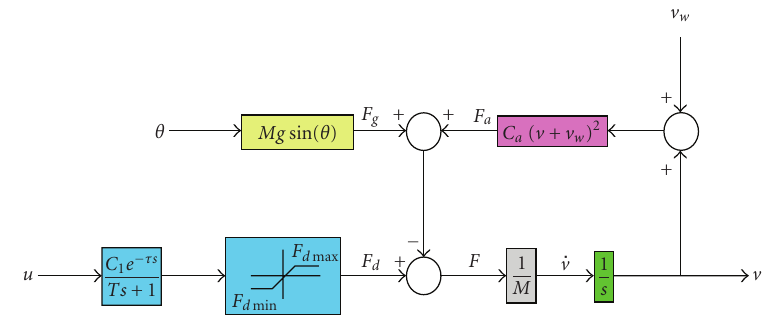
Figure 2: A block diagram by Dorf and Bishop [20].